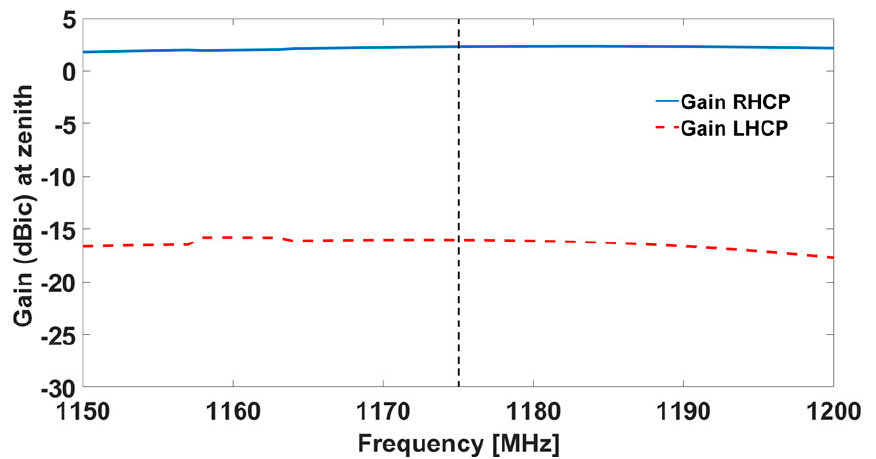
Figure 7. Gain as measured in the CTR chamber for the central antenna: the solid line is the RHCP, while the dotted line is the LHCP.